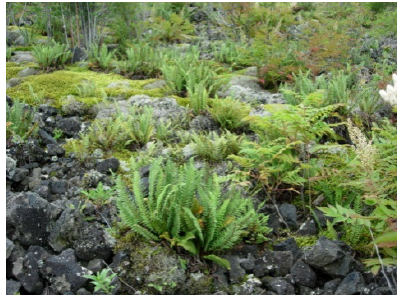
Figure 1. D. fragrans in the lava cracks of the Wu-Da-Lian-Chi